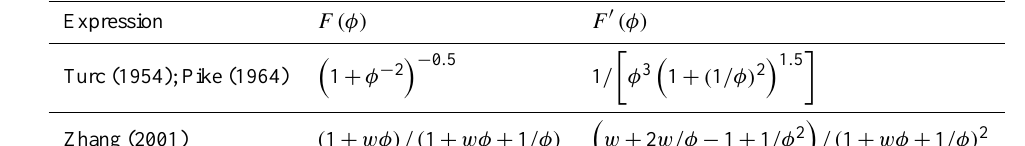
Table 1. Different formulae for the Budyko hypothesis.